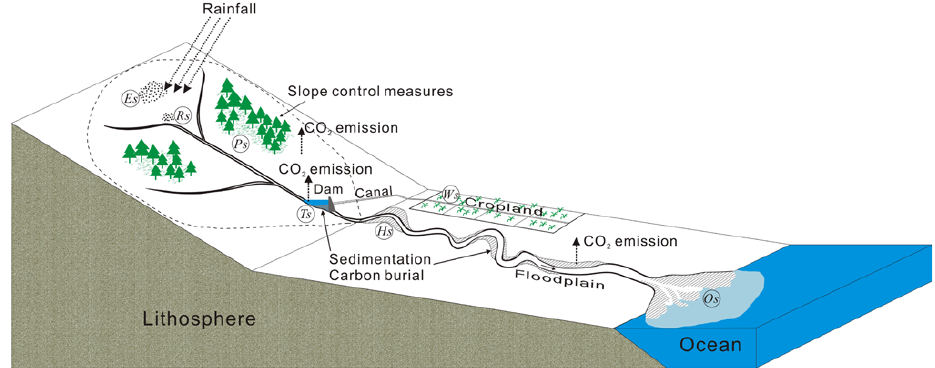
Fig. 2. A conceptual diagram showing production, transport, and deposition of bulk sediment and organic carbon within a river basin, as well as the impact of human activity. The budget terms are explained in the